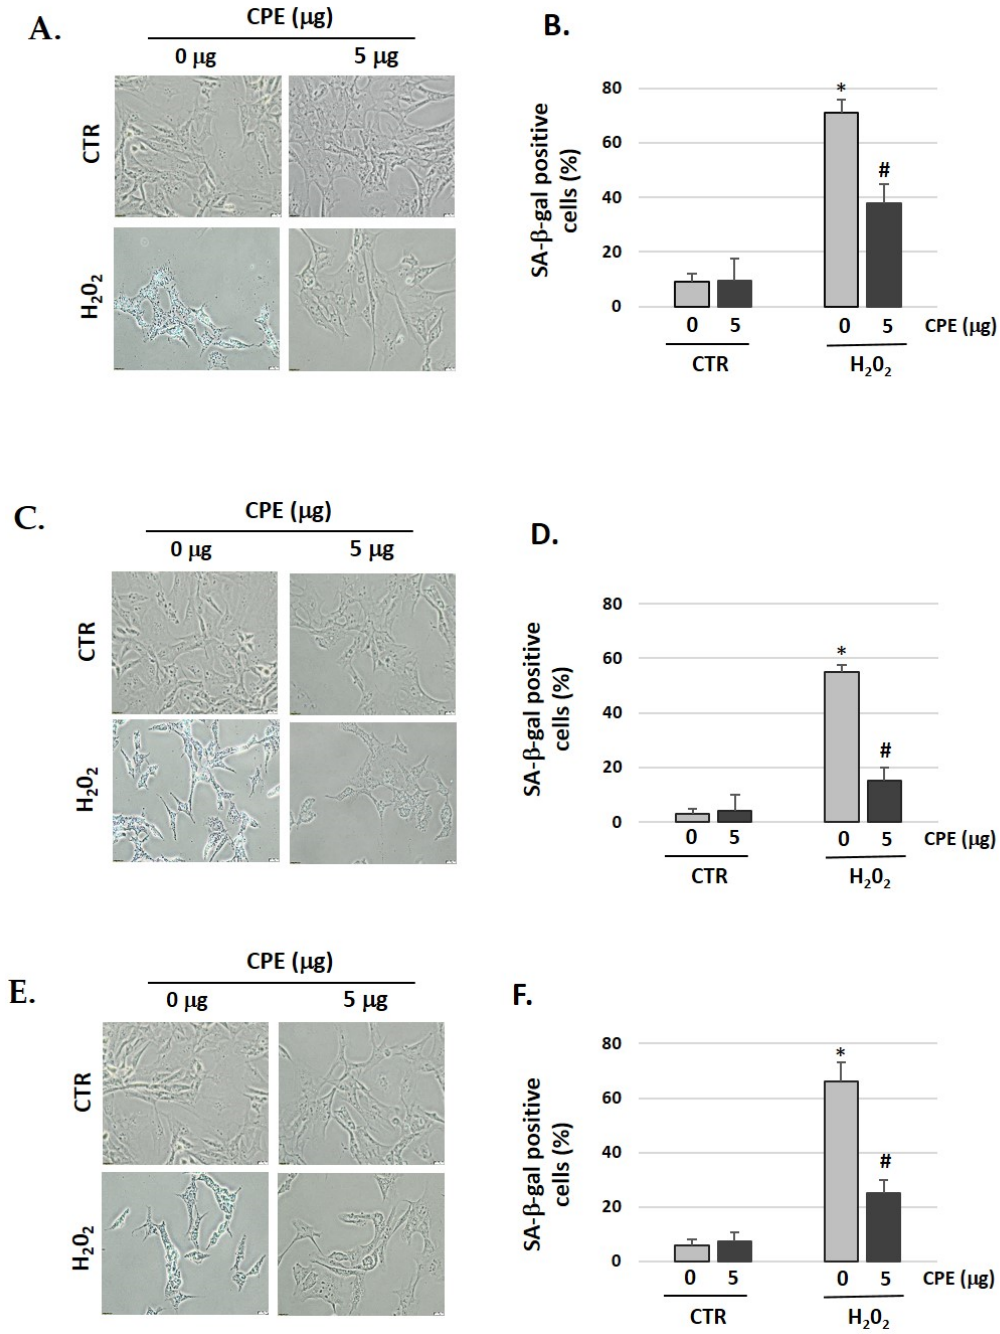
Figure 2. Cocoa reduces premature senescence in auditory cells . Representative SA- β -gal staining of: ( A ) HEI-OC1 cells; ( C ) OC-k3 and ( E ) SV-k1, post-treatment; ( B , D , F ) Percentage of SA- β -gal stained cells post-treatment. Experimental groups: CTR group (0 and 5 µ g/mL of CPE for 20 h) and H 2 O 2 group (CPE pre-treatment at 0 and 5 µ g/mL for 20 h and H 2 O 2 -post-treatment at 100 µ M for 1 h). Data are means ± S.D (n = 3). * p < 0.05 vs. of CTR group (0 µ g of CPE); # p < 0.05 vs. H 2 O 2 group (0 µ g of